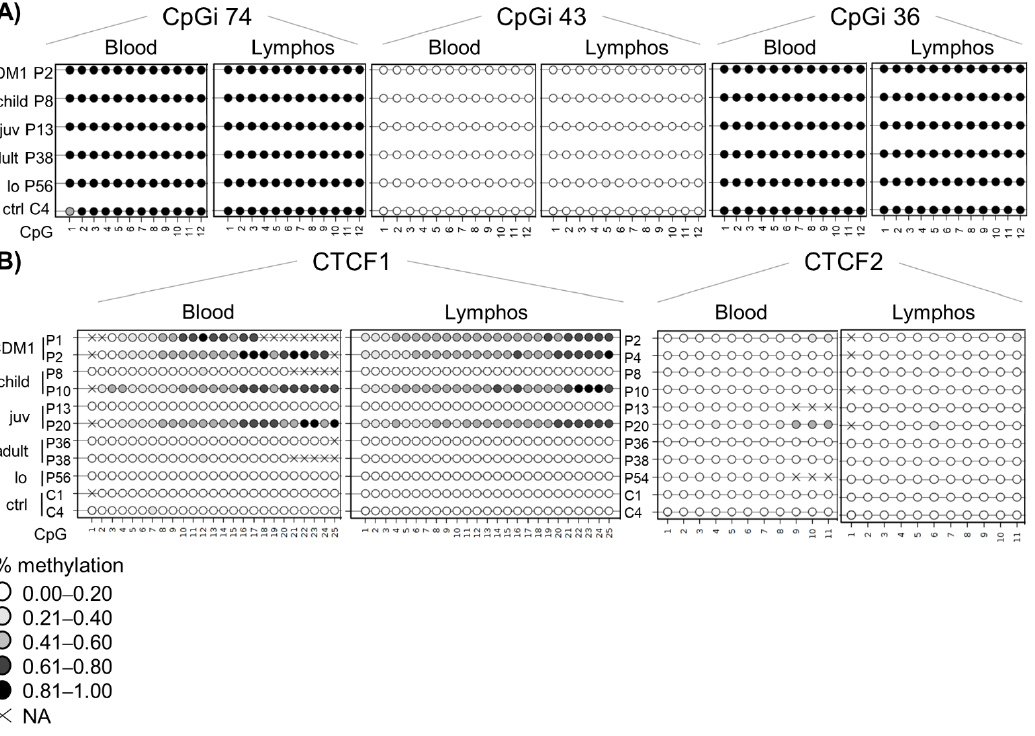
Figure 3. DNA methylation profile is preserved at the DMPK locus in patient-derived lymphoblas- toids. Comparison of the DNA methylation profile between blood and lymphoblastoid cell lines of the same individual across the five annotated CpG regions: ( A ) CpGi 74, 43 and 36. ( B ) CTCF1 and CTCF2. Each circle represents a CpG dinucleotide. The colour gradient represents the level of meth- ylation indicated in the legend assessed by sodium bisulphite sequencing. Abbreviations: C= con- trol, P= DM1 patient; CDM1= congenital, child= childhood, juv= juvenile, lo= late-onset, ctrl= con- trols, lymphos= lymphoblastoids.